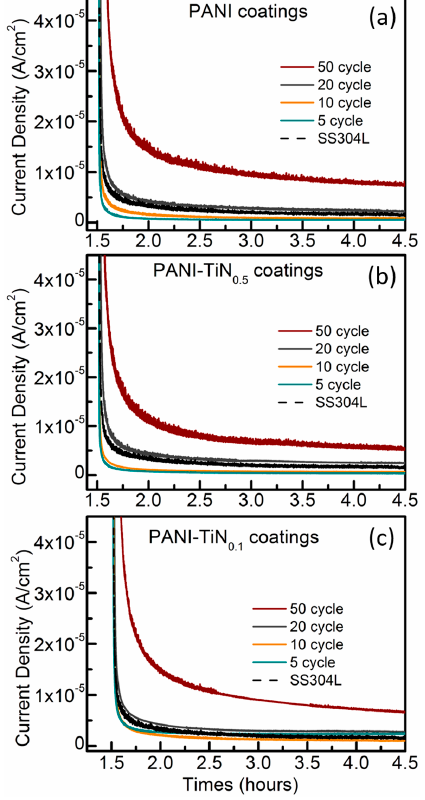
Figure 5. Potentiostatic corrosion profiles for ( a ) PANI ( b ) PANI-TiN 0.5 , and ( c ) PANI-TiN 0.1 coatings with varied coating cycle thicknesses. Table 3. Comparison of the best ICR, E corr , and j corr values of this work with those of other recently-reported studies on TiN-based coatings on stainless